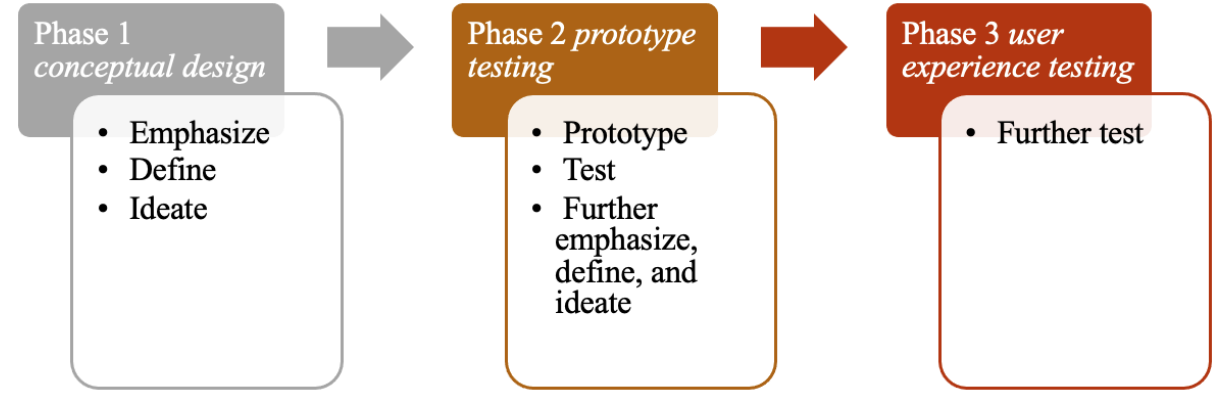
Figure 1. The 3 phases of participant co-design based on the design thinking